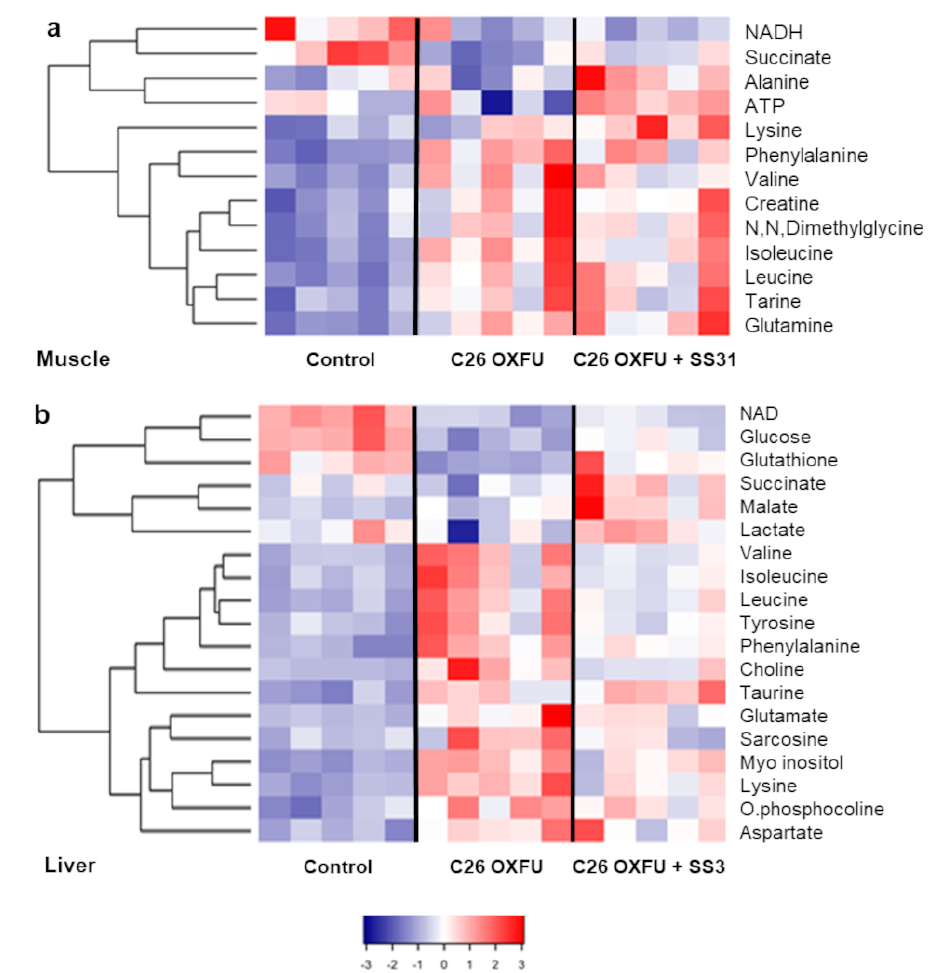
Figure 5. SS31 differentially impacts muscle and liver metabolome. Heatmaps of ( a ) muscle ( b ) and liver metabolites of controls ( n = 5) and tumor-bearing mice administered with chemotherapy alone (C26 OXFU; n = 5) or in combination with SS-31 (C26 OXFU + SS-31; n = 5) at day 21 after tumor implantation. Colors represent z-scores and metabolites are presented with hierarchical cluster